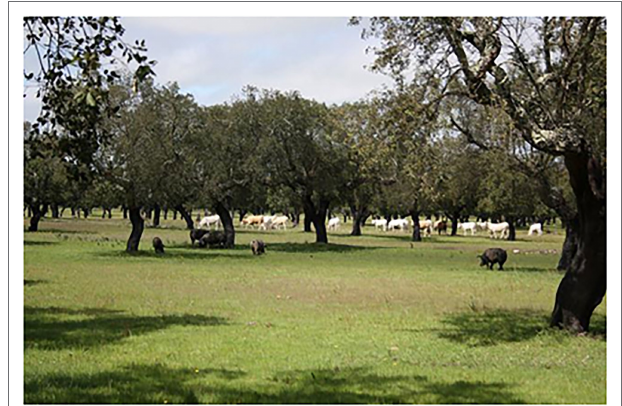
FIGURE 6 | Image for the category of broadleaved evergreen forest (Portugal). Source : AGFORWARD project. Reproduced with permission from João HN Palma, AGFORWARD project, available at https://www.agforward.eu/montado-in-